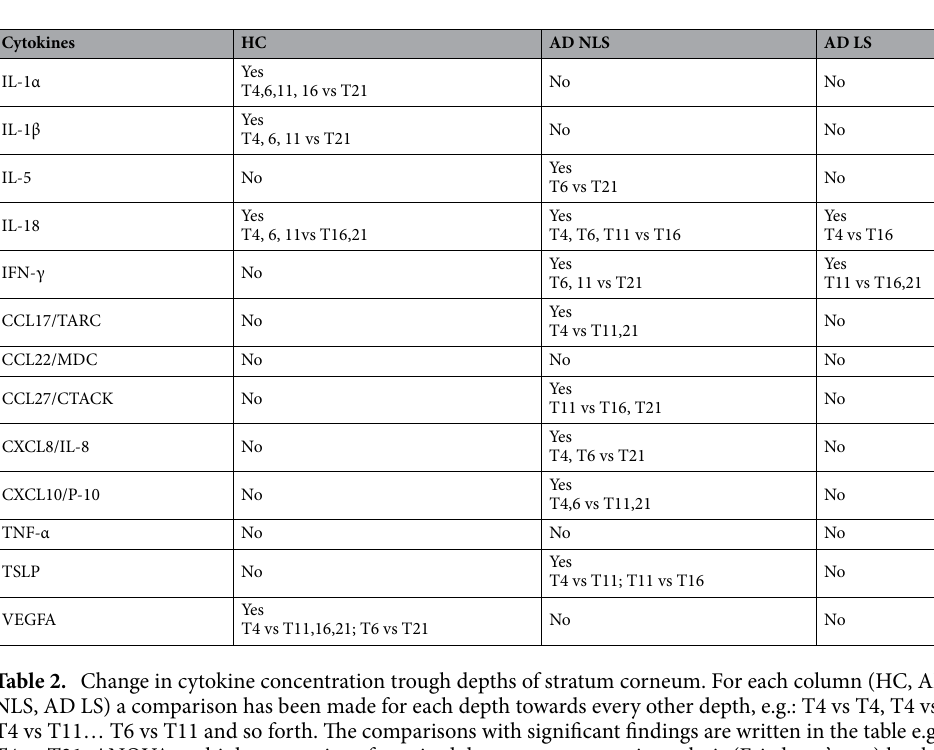
For soluble protein, a significant difference for mean protein content was found between AD LS and AD NLS (corrected p-value < 0.02) and between AD LS and HC (corrected p-value 0.03) (Fig. S3.)